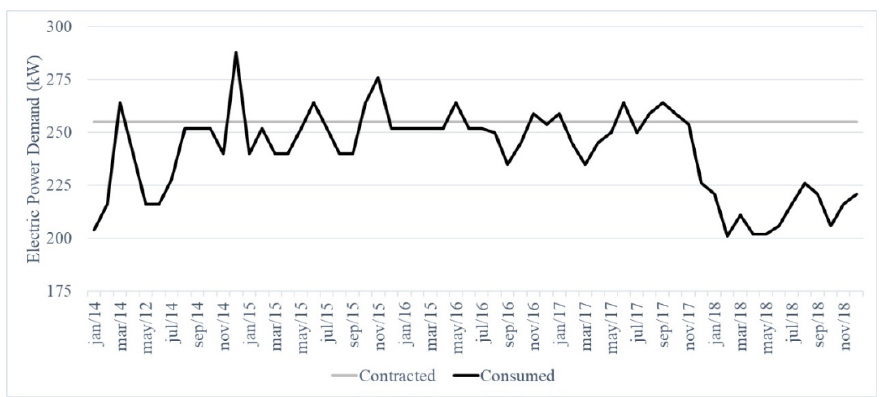
Figure 3. Demand for contracted and consumed electrical power over time.